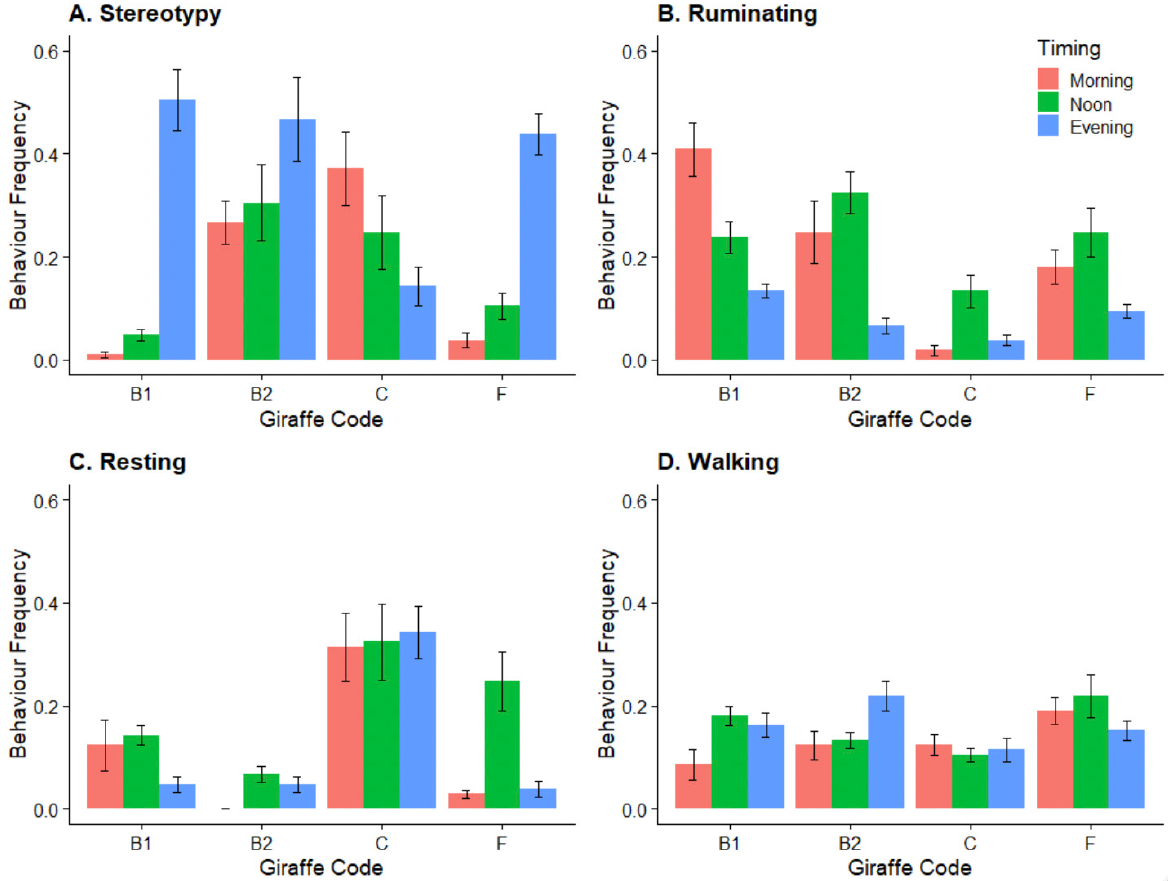
Figure 3. Behaviour across half-hourly blocks among all four giraffe during total observation at Zoological Garden